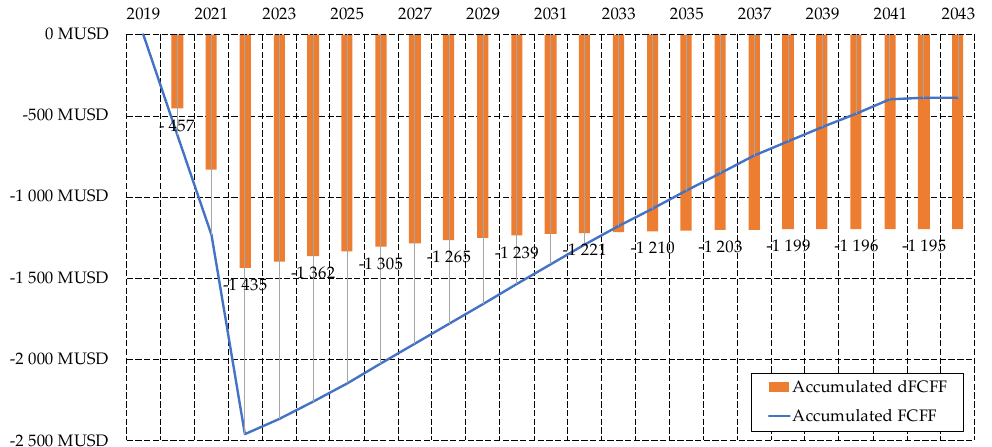
Figure 6. The results of the economic analysis (accumulated cash flow) of scenario 1—HM, FCFF—free cash flow for the firm, dFCFF—discounted FCFF (QVISTORP growth, QVISTORP calculation).